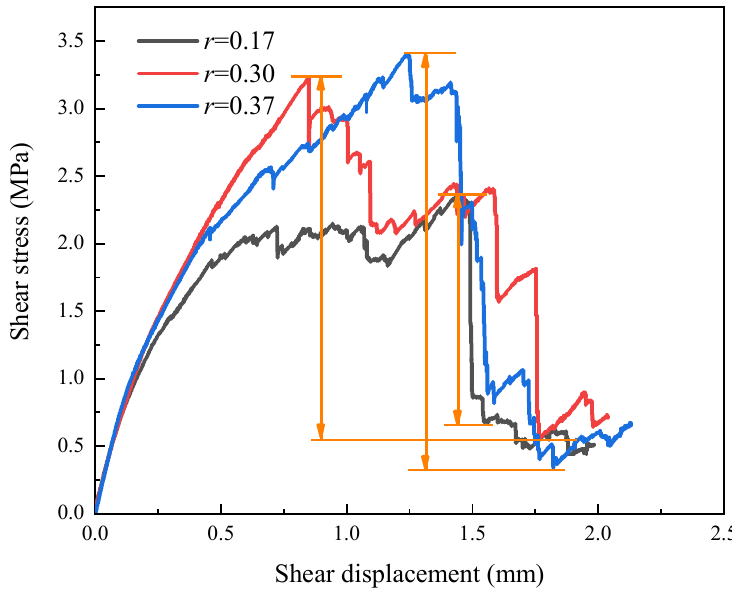
Figure 3. Shear stress – shear displacement curve under different roughness. The correlation between shear strength and dentate joint roughness is depicted in Figure 4. Figure 4 illustrates how closely the joint’s shear strength and roughness are connected. Under the same positive load (2 MPa), the structural surface’s shear resistance varies significantly. According to the fluctuation trend between shear strength and rough- ness, shear strength rises as roughness rises. When the joints’ roughness rose from 0.17 to 0.30, the shear strength of the dentate joints improved by 37.3%. Peak shear stress increased by 5.94% compared to the peak shear stress of 3.2 MPa for joints with a roughness of 0.30 and reduced as the joints’ roughness reached 0.37. It makes sense that the resistance to slip along joints increases to resist shear as joint roughness increases. The contact interac- tion between the joints will degrade once the roughness of the joints reaches a particular value. The first contact point will experience increased stress during the application of positive stress, and high local stress has reached yield or peak stress and local failures. Thus, during shear loading, the increase in shear strength becomes progressively smaller as the roughness of the joints